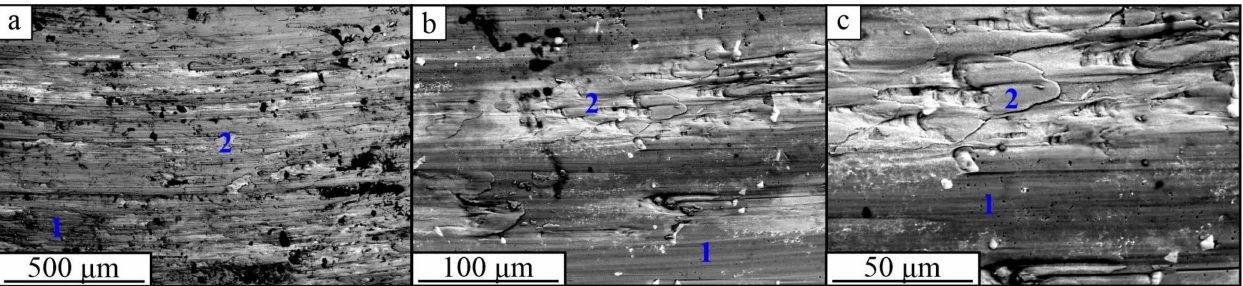
Figure 17. SEM BSE images of the worn surface zones on the FSW tool shoulder ( a – c ): 1—intermetallic regions,